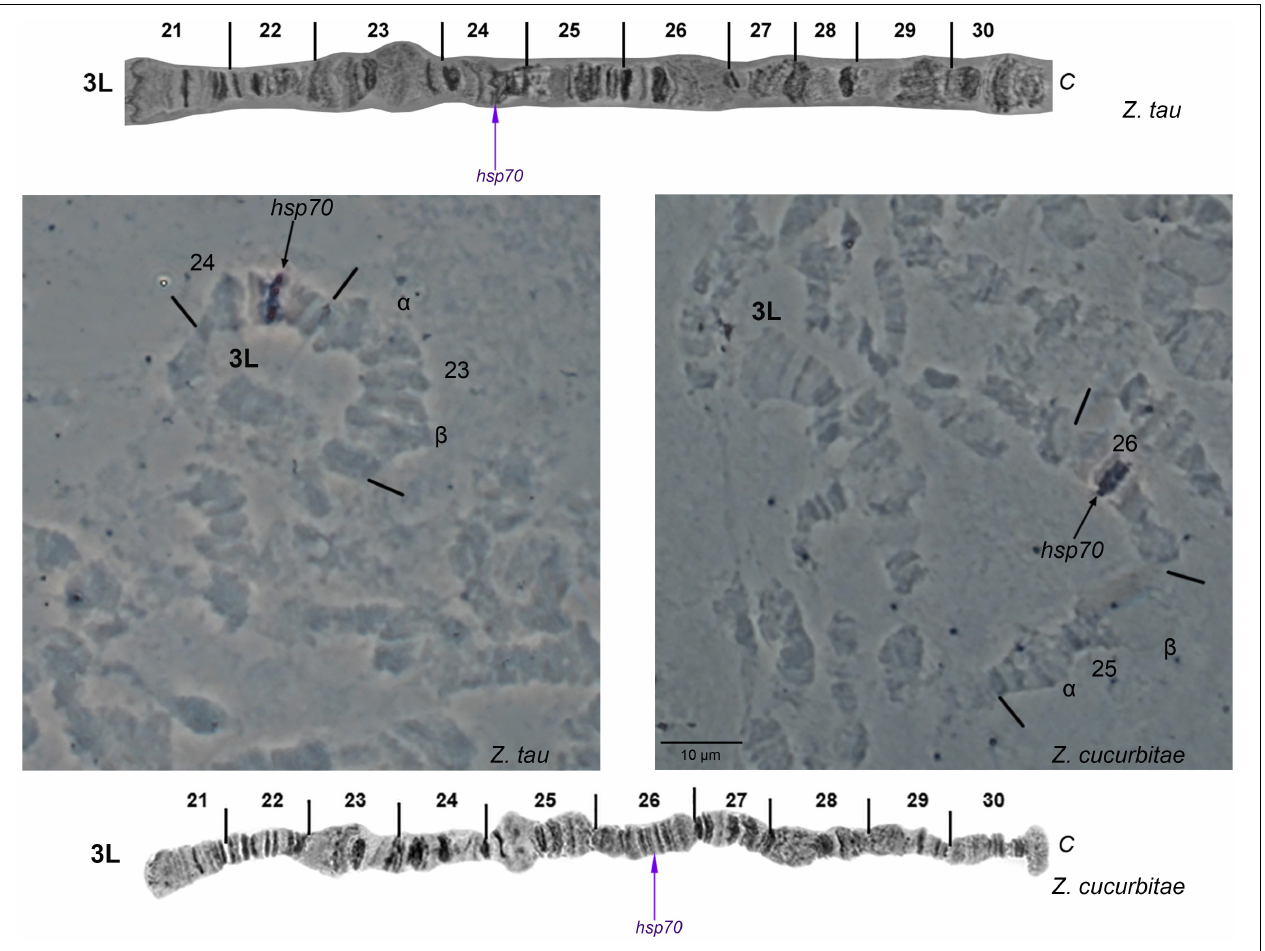
FIGURE 6 | In situ hybridization of the hsp70 probe with the 3L polytene chromosome arm of Zeugodacus tau and Zeugodacus cucurbitae . Arrows indicate the hybridization signals. The chromosome tips are indicated. Numbered divisions are shown, separated by lines. The corresponding reference map of 3L arm of Zeugodacus tau is presented on the top, and that of Zeugodacus cucurbitae at the bottom modified from Figure 7 of: Zacharopoulou et al.